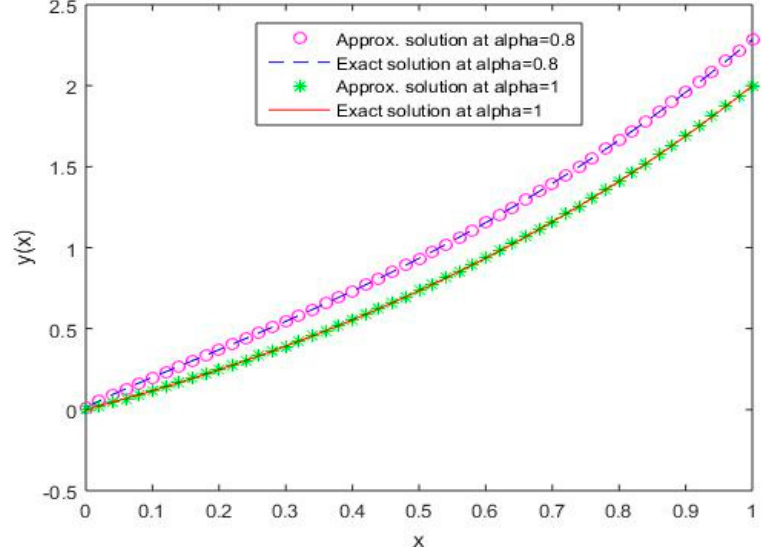
Figure 11. Comparison of exact and numerical solutions using S1 for 𝛼 = 0.8 and 𝛼 = 1 , Example 2.